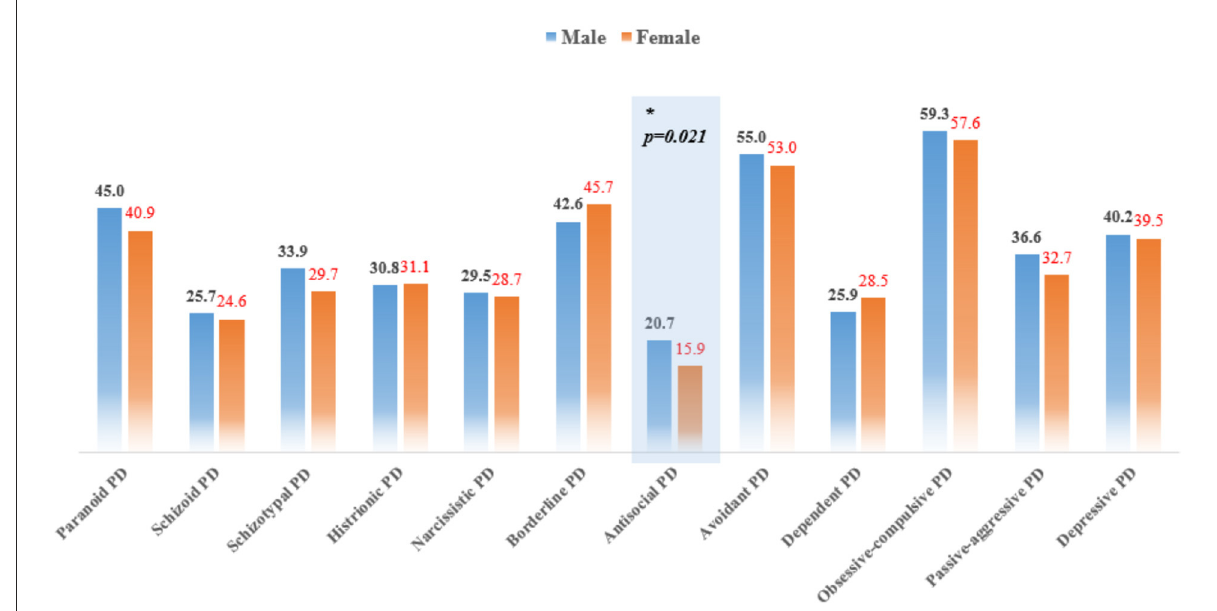
FIGURE1 Frequency of PDQ-4 + self-reported PDs, compared between male and female outpatients. Comparisons were evaluated with the χ 2 -test.